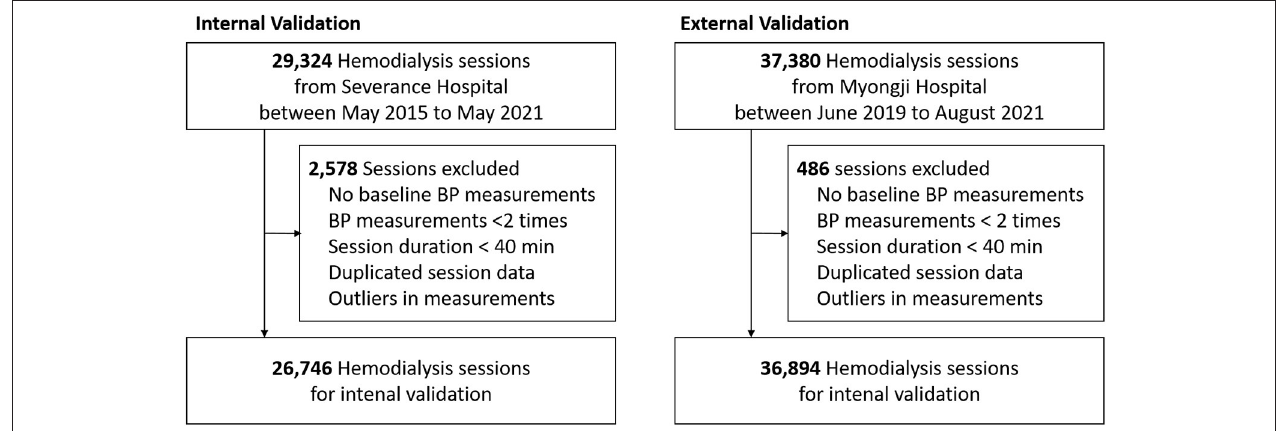
FIGURE 1 | Flowchart of this study. BP, blood pressure.